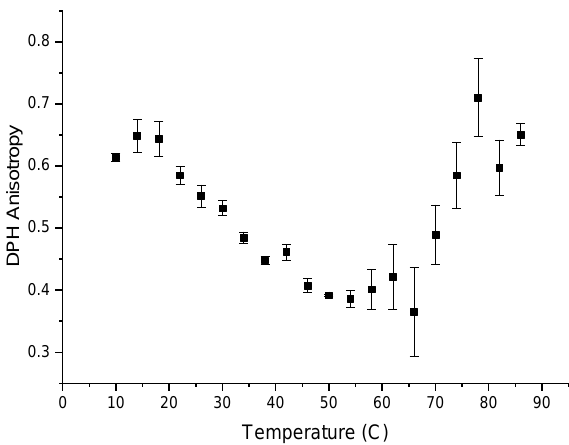
Figure 5. Anisotropy measurement of 1-6-diphenyl-1,3,5-hextriene (DPH) that was intercalated into α -glucan nanoparticles.